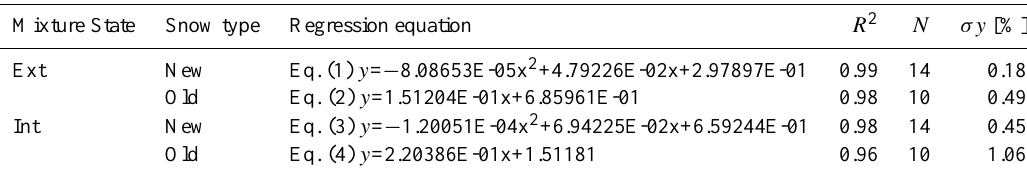
Table 3. Regression equations of each mixture state of BC and snow type. Mixture State